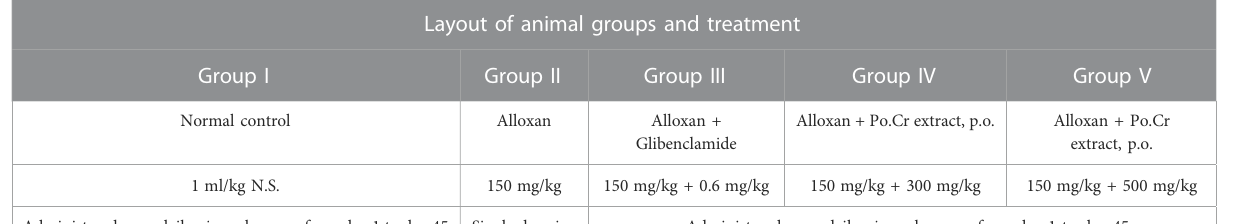
TABLE 1 Layout of animal groups and treatment of the alloxan-induced diabetic rat